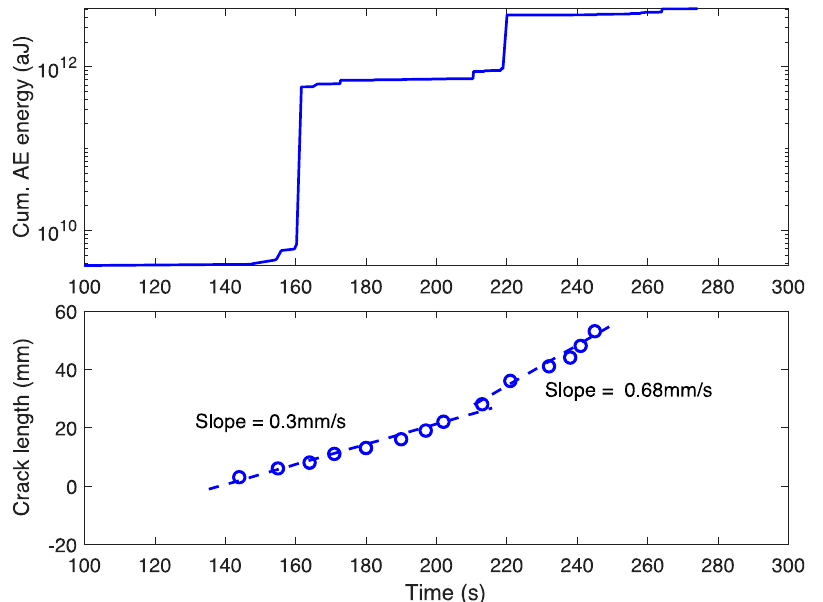
Figure 10. Evolution of the cumulated AE energy and the crack length velocity as a function of time.